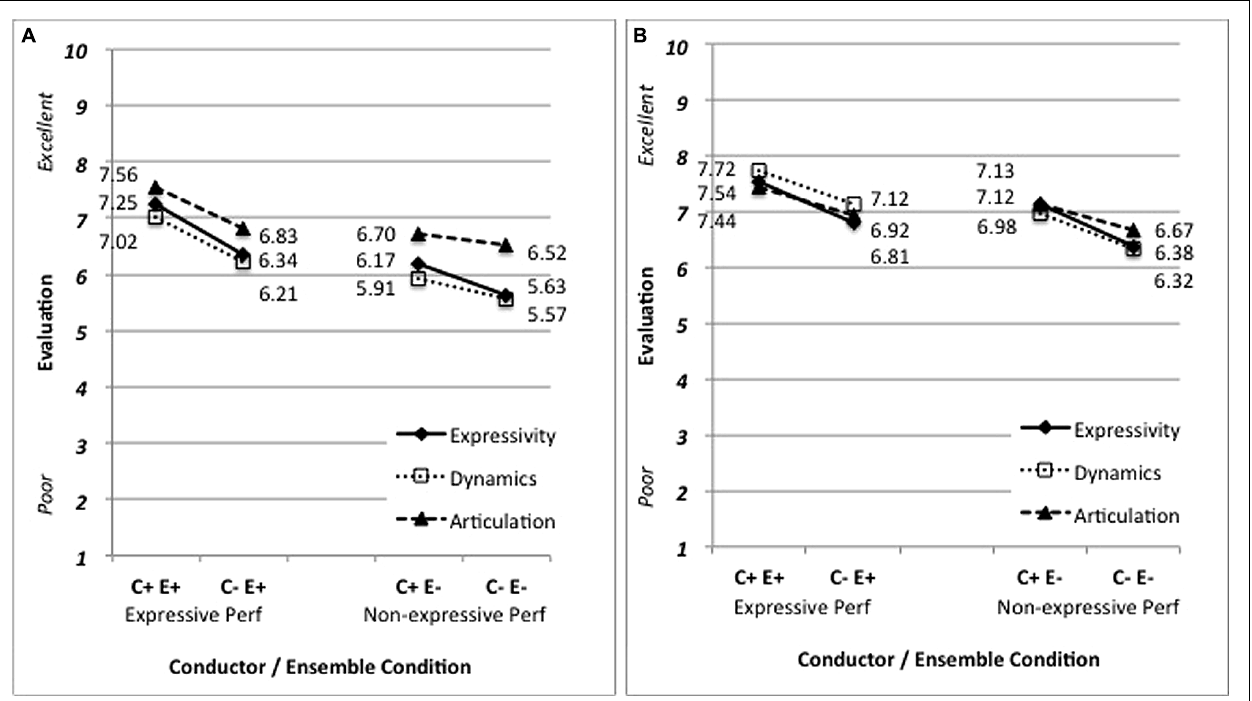
FIGURE 3 | Mean evaluations for examples targeting (A) articulation and (B) dynamics.